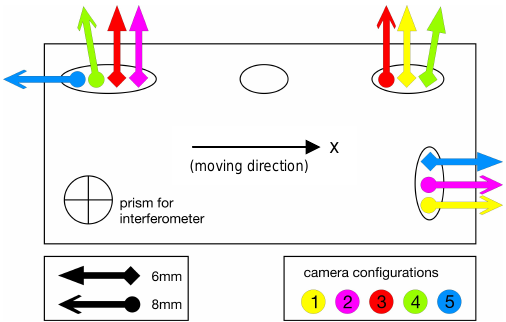
Figure 6. Camera configurations for scenario (I). Each pair of equally coloured arrows denotes a configuration, arrowheads show the used